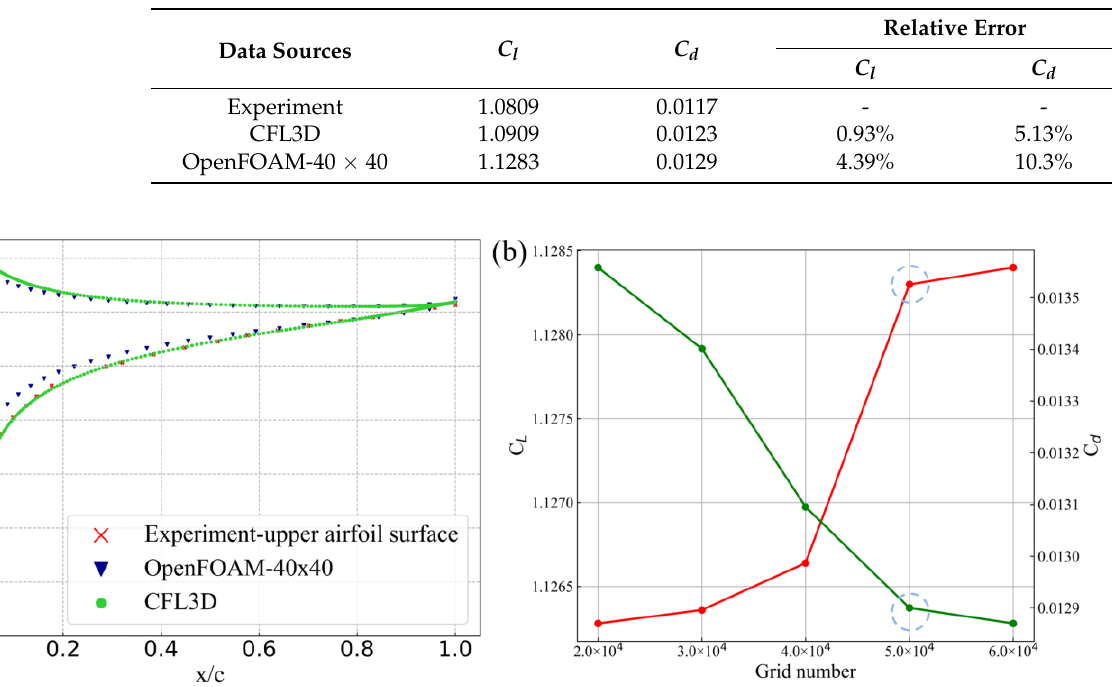
Table 2. Comparison of lift and drag coefficient from different data sources.